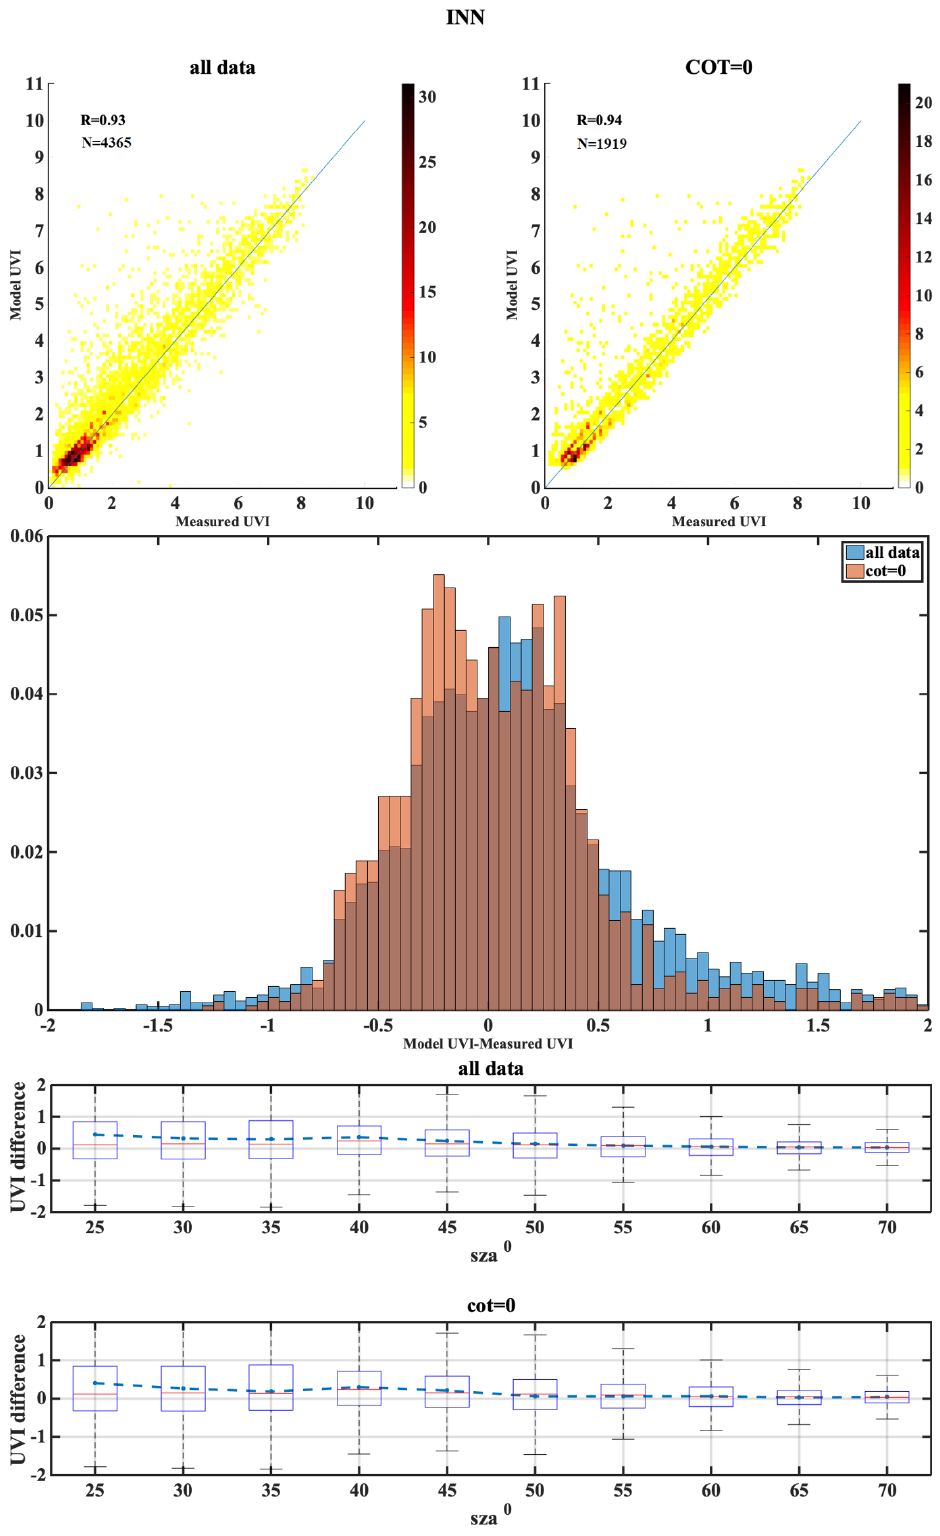
Figure A8. Same as above but for the INN